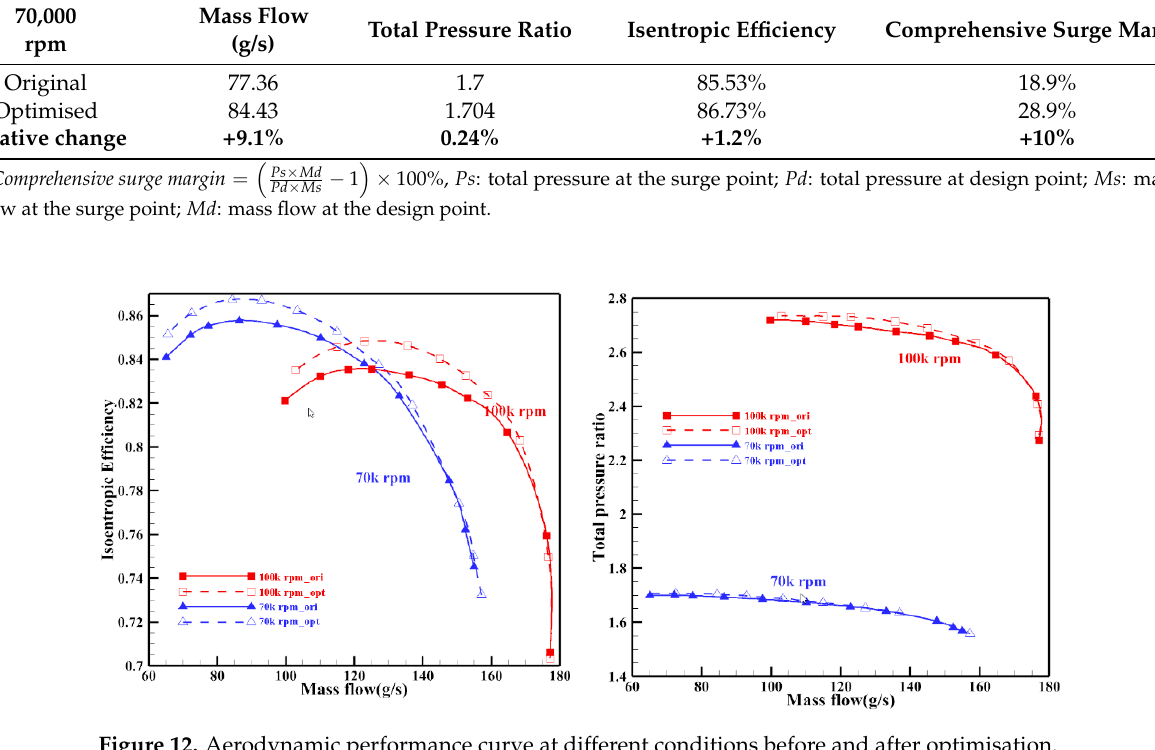
Table 8. Comparison of the performance at the design point before and after optimisation (common operating condition).